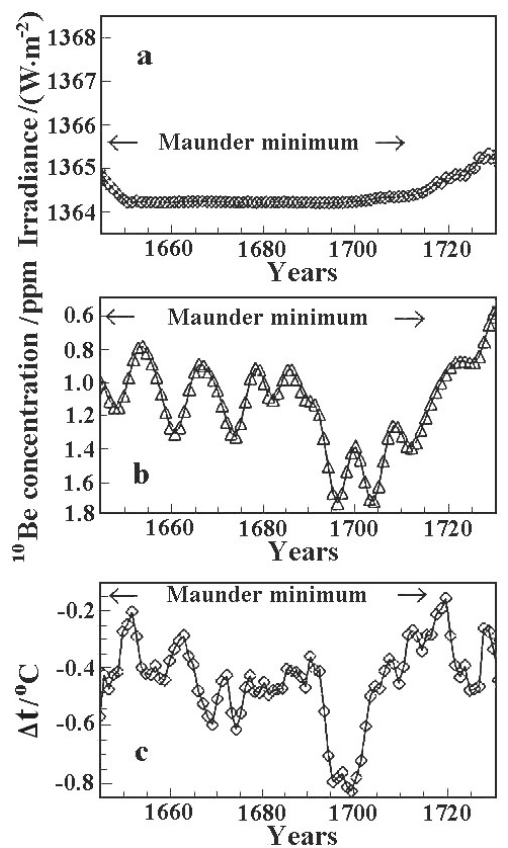
Fig. 5. Situation in the Maunder minimum: (a) – reconstructed so- lar irradiance (Labitzke and Van Loon, 1993); (b) – CR intensity according to concentration of 10 Be (Beer et al., 1991); (c) – re- constructed relative change of air surface temperature, 1t , for the Northern Hemisphere (Jones et al., 1998). According to Svens- mark